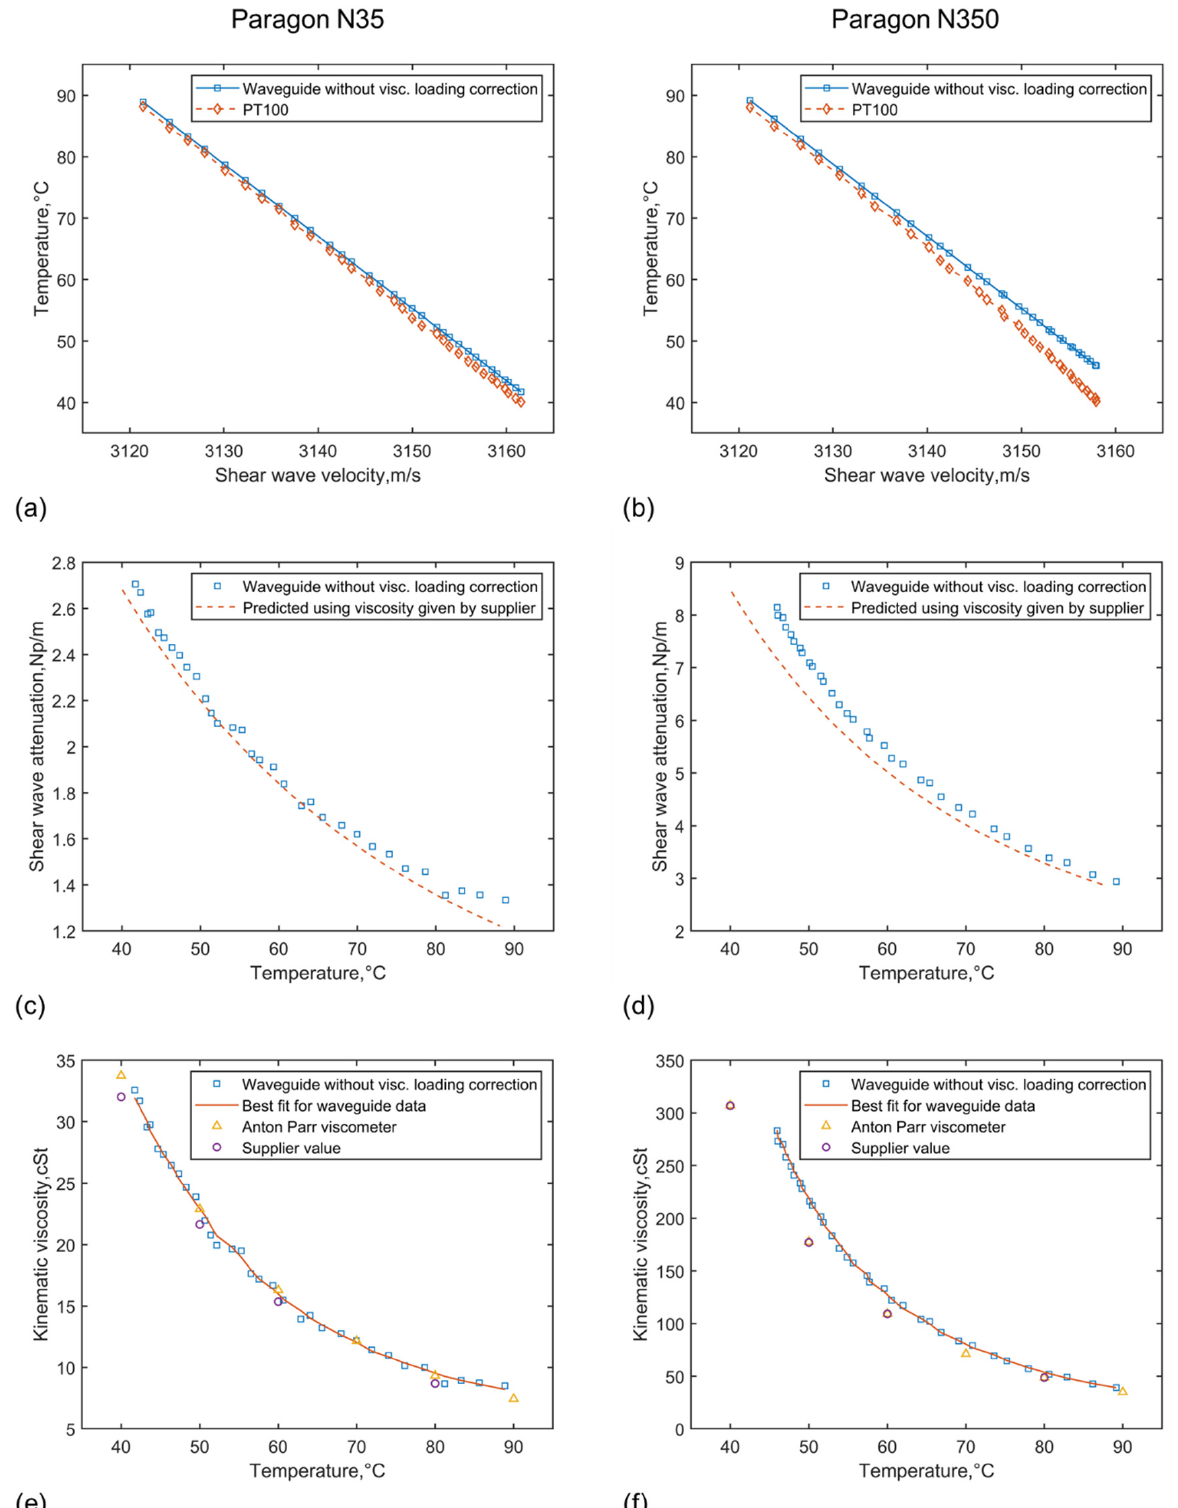
Figure 7. Temperature predicted, attenuation measured and viscosity predicted for Paragon N35 ( a , c , e ) and Paragon N350 ( b , d , f ), where the temperature is compared with measurements with PT100, the attenuation is compared with that predicted using the kinematic viscosity provided by the viscosity standard supplier, and the viscosity predicted is compared with measurements using the Anton Parr viscometer and the values provided by the viscosity standard supplier (results for predictions without correcting for viscous fluid loading effect on the wave velocity).